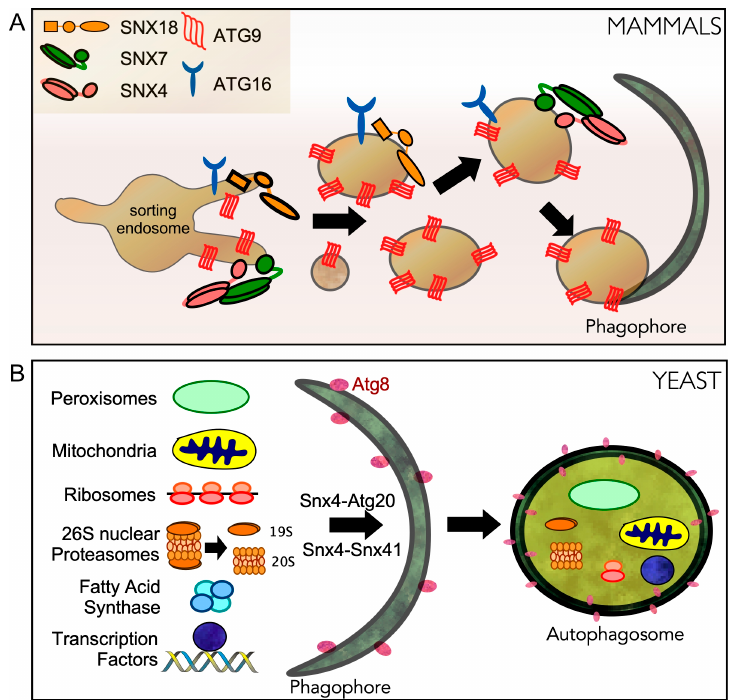
Figure 4 Figure 4. Sorting nexins play critical roles in autophagy following starvation stress. ( A ) In mammalian cells, SNX4/SNX7 and SNX18 are required for autophagy-dependent localization of ATG16 and ATG9 from recycling endosomes to the pre-autophagosomal site (PAS). ATG9 containing vesicles are required for PAS formation and autophagosome biogenesis. ( B ) In yeast, Snx4-Atg20 (Snx42) and Snx4-Snx41 heterodimers regulate different forms of selective